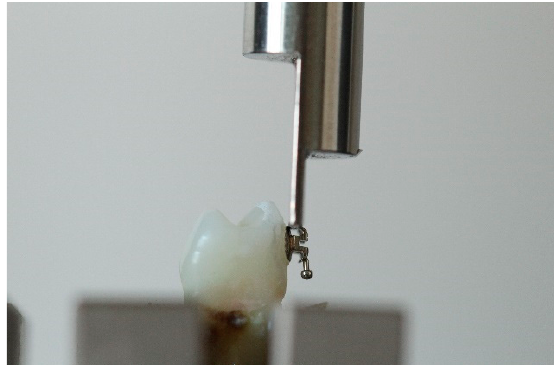
Figure 6. Pin pressing on conventional